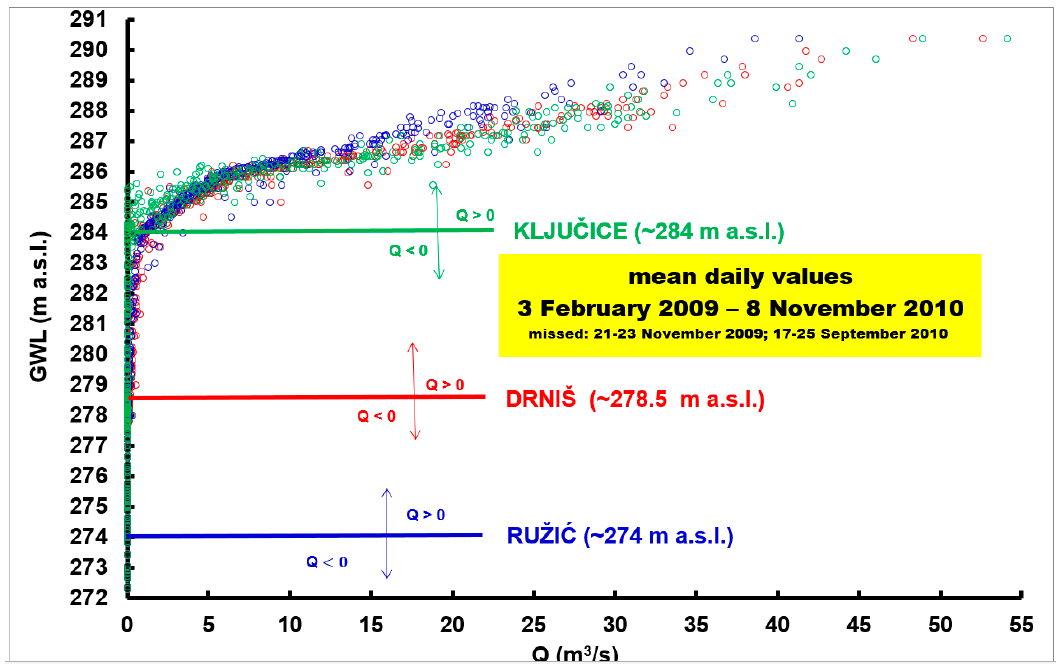
Figure 9. Relationship between the mean daily groundwater level, GWL (m a.s.l.), and the mean daily discharges, Q (m 3 /s), measured at Ruži ć , Drniš, and Klju č ice hydrological stations over